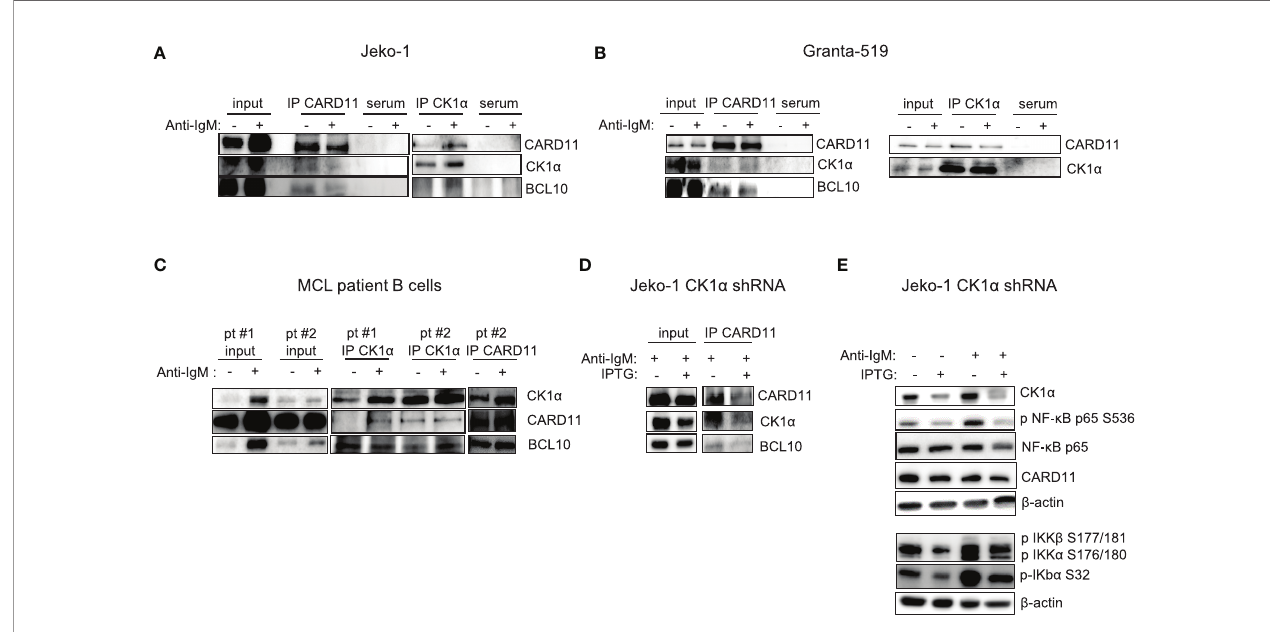
FIGURE 4 | CK1 a associates with the CBM1 complex, and its silencing reduces basal and anti-IgM induced NF-kB activation. (A) Immunoprecipitation (IP) of CARD11 and CK1 a in Jeko-1 (A) , Granta- 519 (B) , puri fi ed B lymphocytes from two MCL patients (pt#1 and pt#2) (C) , stimulated with anti-IgM 10µg/ml for 5 min (serum= preimmune serum). (D) CK1 a silencing reduces the binding of CK1 a to CARD11 and BCL10 in the CBM1 complex in anti-IgM stimulated Jeko-CK1 a shRNA inducible clone. Untreated and IPTG treated (500µM for 72h) Jeko-1 cells from the CK1 a shRNA cellular clone were stimulated with anti-IgM 10µg/ml for 5 min and IP was carried out using CARD11 antibody. (E) CK1 a silencing affects basal and anti-IgM stimulated NF- k B activation. Cells were treated as in (D) . WB was probed with antibodies listed in the fi gure. b -actin was used as loading